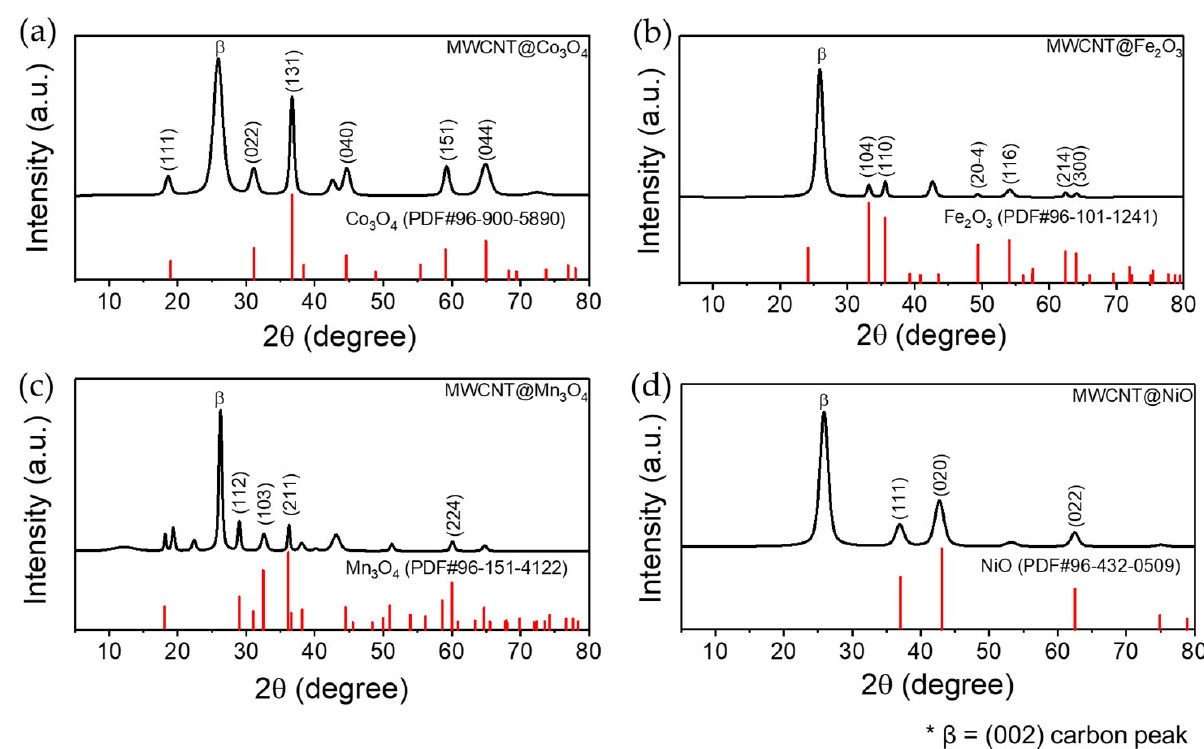
Figure 5. XRD patterns for the CNT composites ( a ) MWCNT@Co 3 O 4 , ( b ) MWCNT@Fe 2 O 3 , ( c ) MWCNT@Mn 3 O 4, and ( d ) MWCNT@NiO. The beta mark is a common peak for carbon (002).